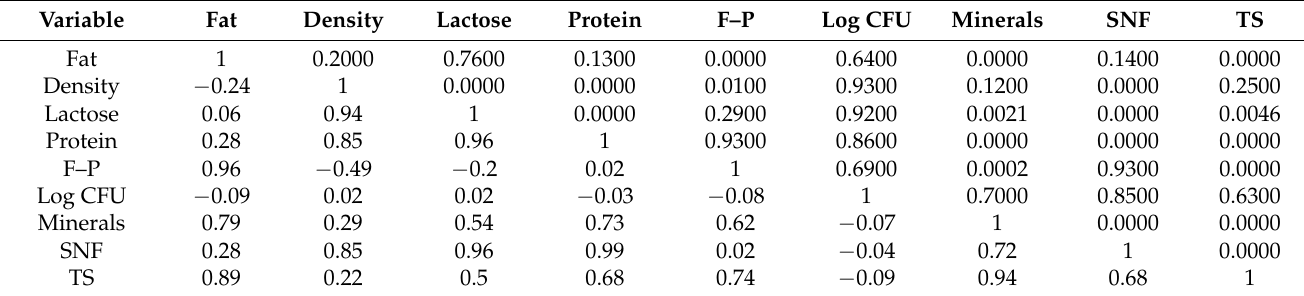
Table 3. Estimated Spearman correlations between milk quality variables in the evaluated dual- purpose systems (coefficients and their significance are below and above the diagonal, respectively).